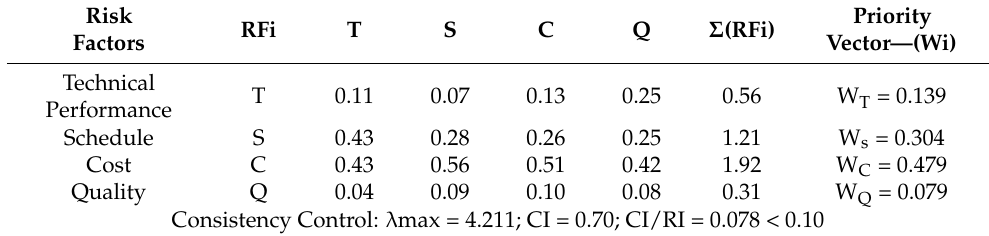
Table 5. Normalized reciprocal matrix and priority vector.